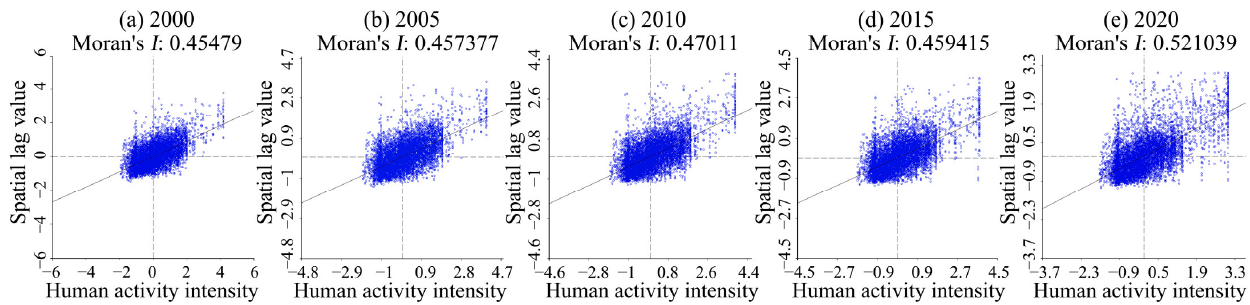
Figure 5. Moran’s scatter plot of changes in human activity intensity and habitat quality in Guiyang from 2000 to 2020.